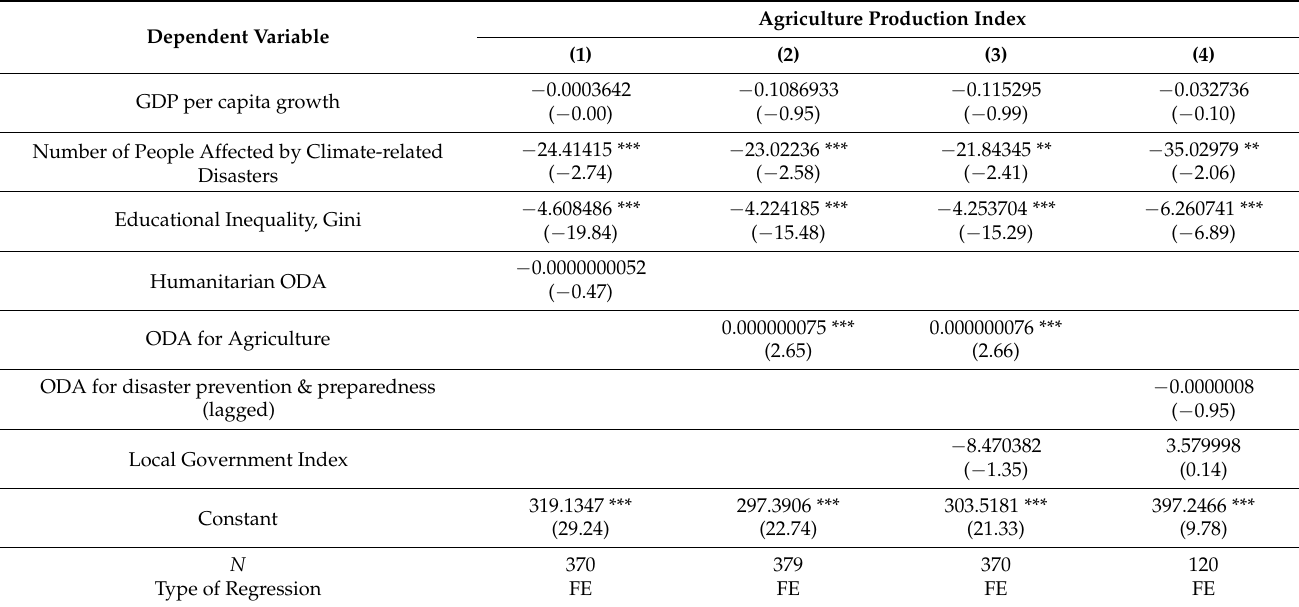
Table 3. Impact on Agricultural Production by Climate-related Disasters and Aid.